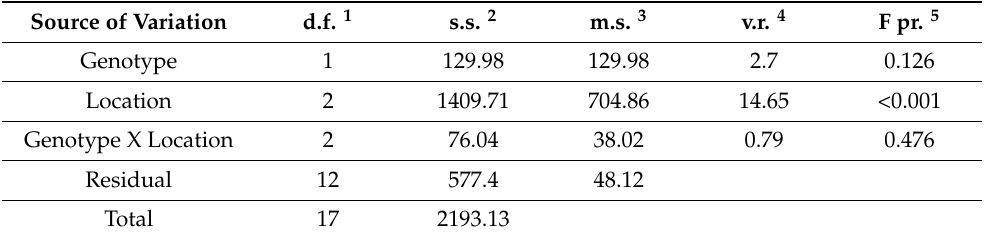
Table 1. ANOVA for yield of marketable tubers between the transgenic event Vic.172 and the variety Victoria at all locations and between locations.